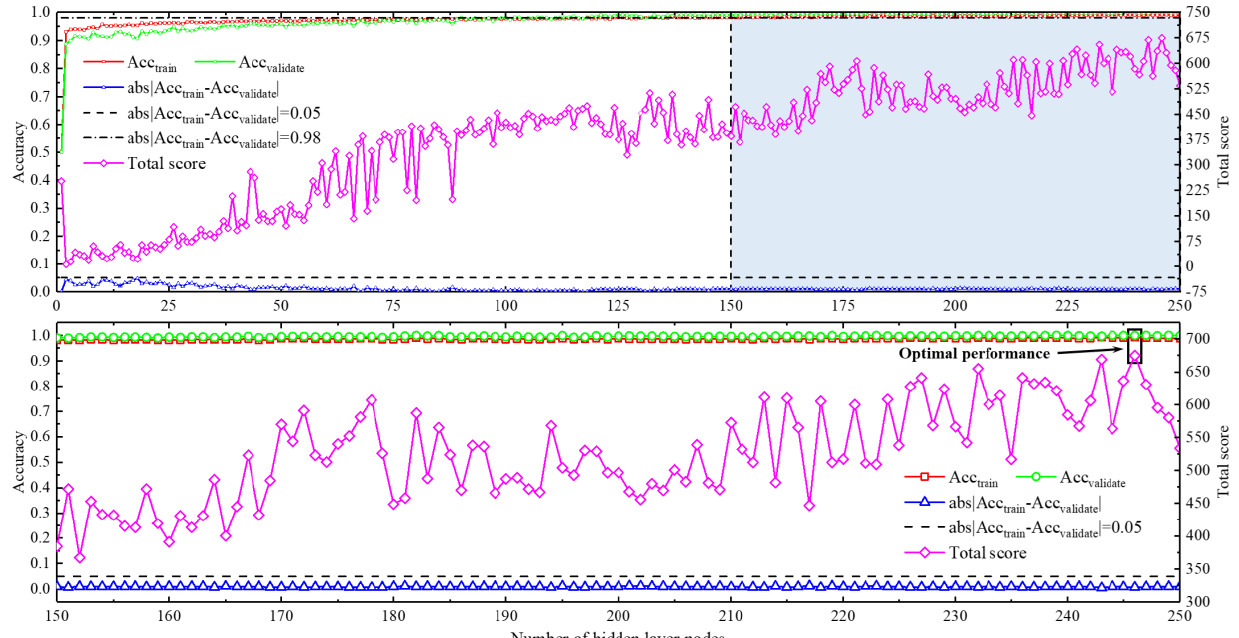
Figure 9. Prediction results of the PSO-ELM model with various HLNs. After NumHLNs in PSO-ELM was determined, the number of particles in the swarm (NPS) and the maximum number of iterations also need to be investigated. Hence, 10 PSO-ELM models with the maximum number of iterations of 1000 and the number of particles from 20 to 350 were established and run five times to predict the training subset (see Figure 10). As shown in Figure 10, there are no significant changes in these accuracy curves after 800 iterations, and 200 is the optimal NPS with the highest prediction accuracy. Thus, 800 and 200 were chosen to establish the final PSO-ELM model for discriminating microseismic events and mine